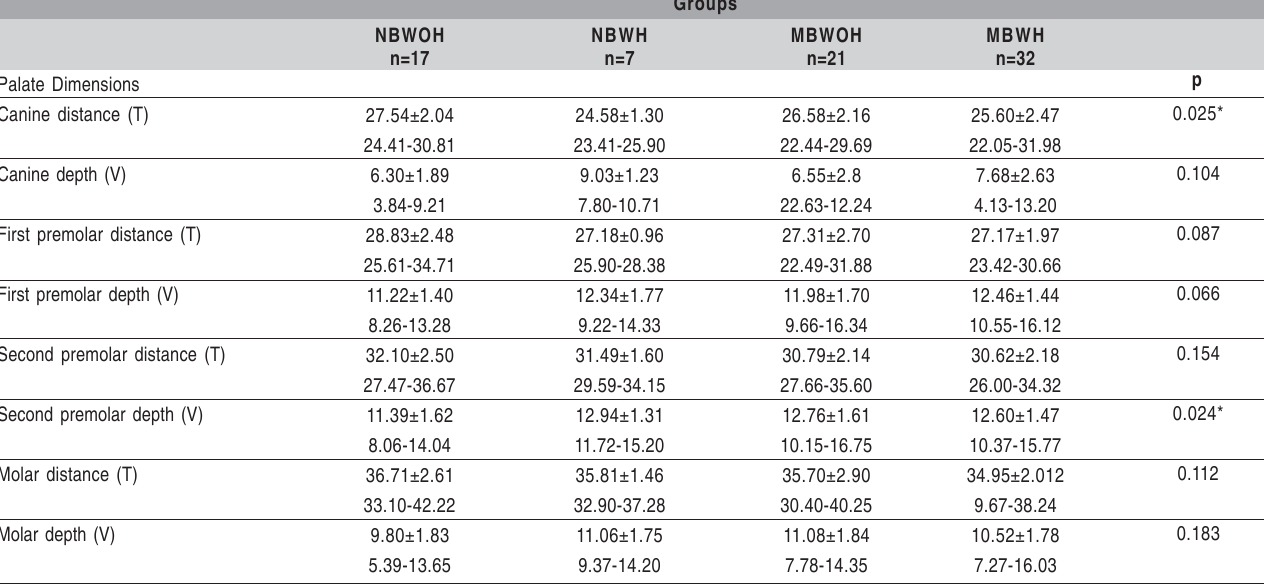
*ANOVA test (p< 0.05); NBWOH= nose breathing without prolonged habits; NBWH= nose breathing with prolonged habits; MBWOH= mouth breathing without prolonged habits; MBWH= mouth breathing with prolonged